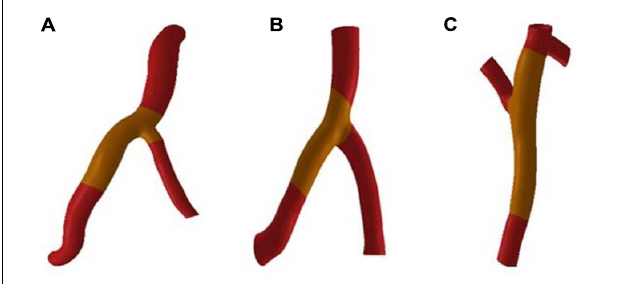
FIGURE 2 | Blood vessel models. (A) RCA (B) LAD (C) LCX.